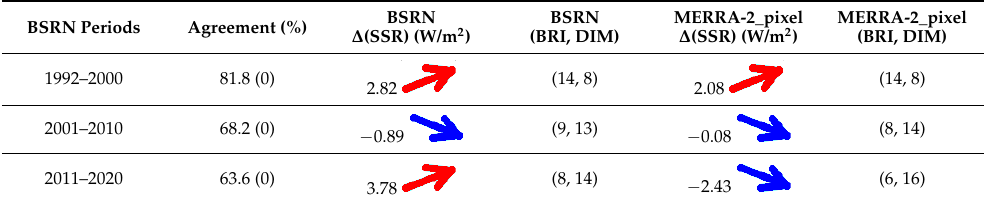
Table 2. Agreement between the GDB (Δ(SSR)) of MERRA -2 and GEBA stations over four different time periods. The percent number of GEBA stations for which same sign of GDB is found with the corresponding MERRA-2 pixels is given (in parentheses are the statistically significant trends), along with the average Δ(SSR) and the number of stations/pixels with brightening and dimming (shown in parentheses) for both GEBA and MERRA-2. Red and blue vectors indicate Brightening and Dimming, respectively.